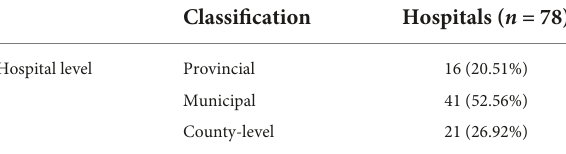
TABLE 1 Levels of hospitals participated in the